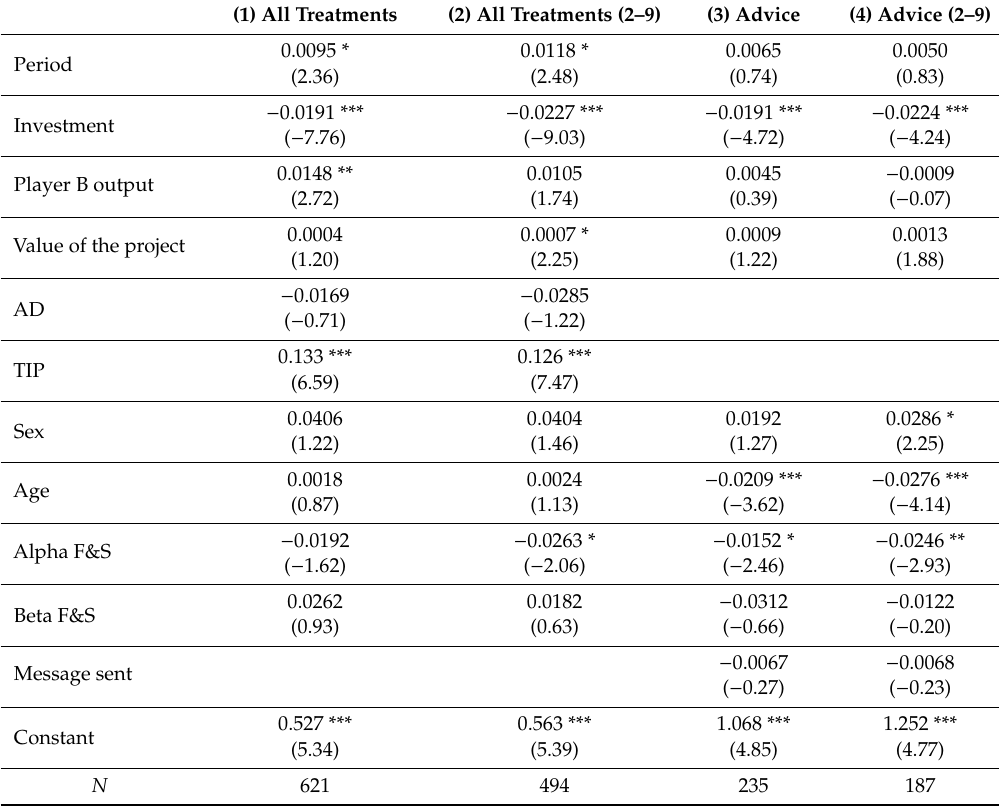
Table 3. Random-effects GLS model for player C’s decision.